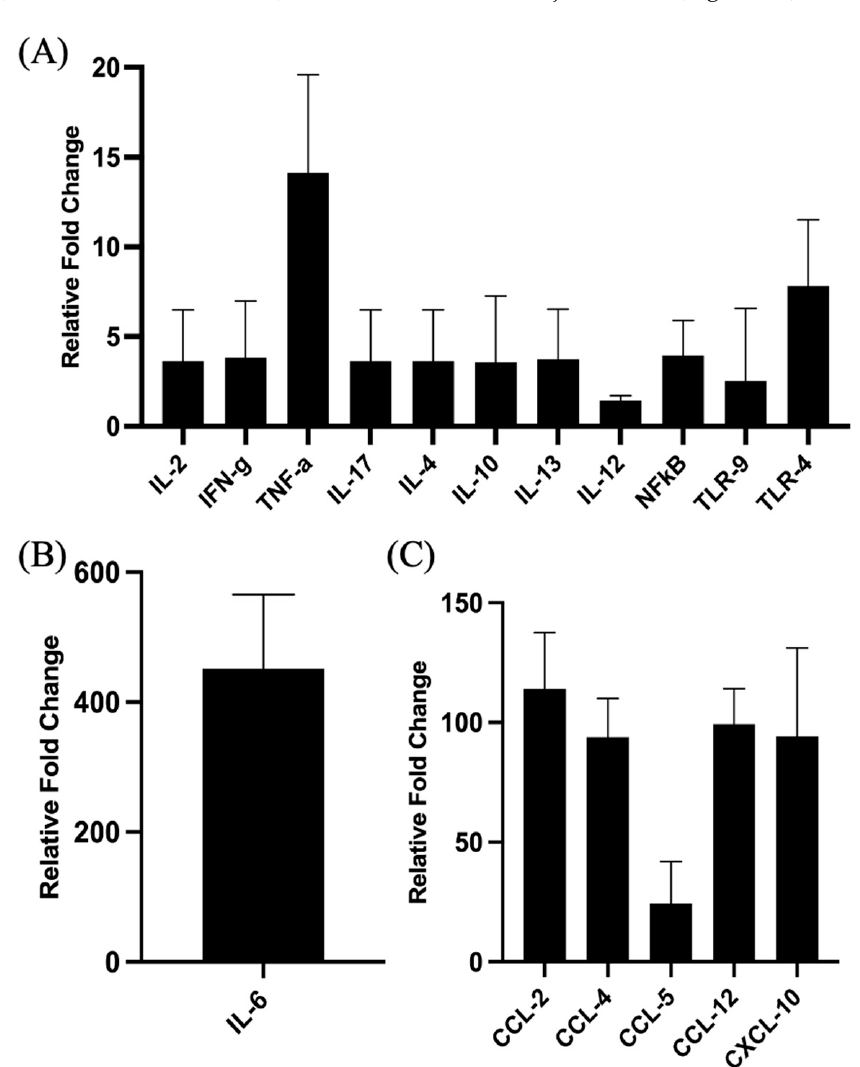
Figure 2. Patterns of Gene Expression at Site of PCEP Injection. Cytokine and chemokine gene expression profiles elicited by PCEP at the site of injection after intramuscular injection in mice. Mice were injected with PBS or PCEP intramuscularly. Muscle tissue at the site of injection were collected at 24 h and analyzed for cytokine and chemokine genes by quantitative real-time PCR. ( A ) Increased expression of cytokine genes including IFN γ , TNF α and TLRs at the injection site. ( B ) Substantial increase in proinflammatory gene, IL-6. ( C ) Increased expression of chemokine receptor family genes at the injection site. Results shown are the mean ± SE of six replicates at each time point. Relative fold changes ( y -axis) for each gene were normalized to mouse GAPDH. Fold changes are calculated by the Ct method and are relative to the gene expression in PBS injected muscle tissue. (reprinted with modifications from Awate et al. 2012, Copyright 2012, with permission from Elsevier).